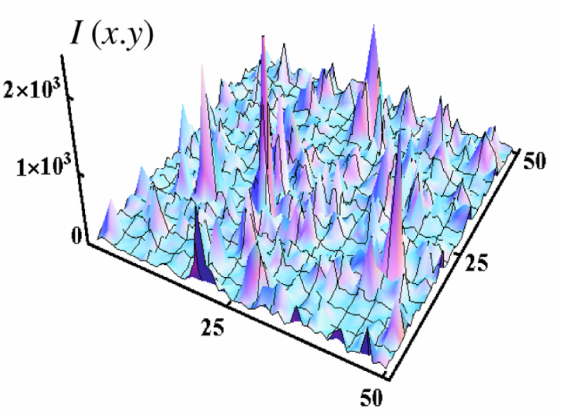
Figure 3. ( a ) gold/glass composite for four metal concentrations p . At percolation threshold p = p c , continuous gold channel spans the system; ( b ) experimental images of the localized optical excitation in a gold/glass composite at percolation threshold ( p = p c ). These images are collected with a SNOM using an excitation wavelength of λ = 780nm, reprinted with permission from [76], Copyright 2007, World Scientific Publishing Co. Pte. Ltd.